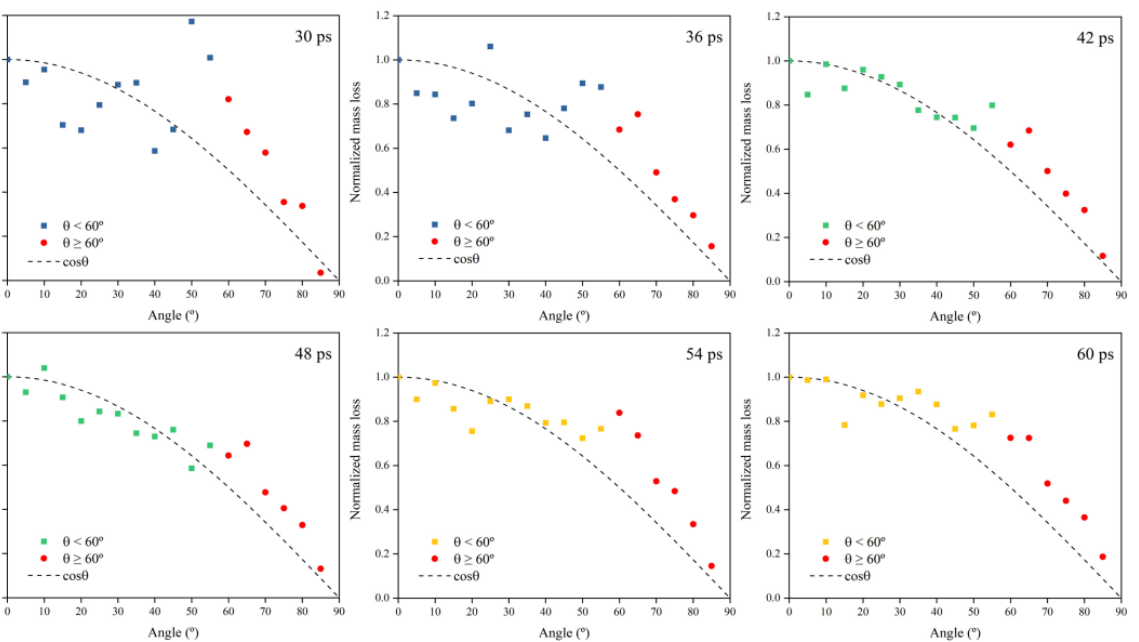
Figure 8. Mass loss of the Kapton during atomic oxygen impact at different incidence angles.